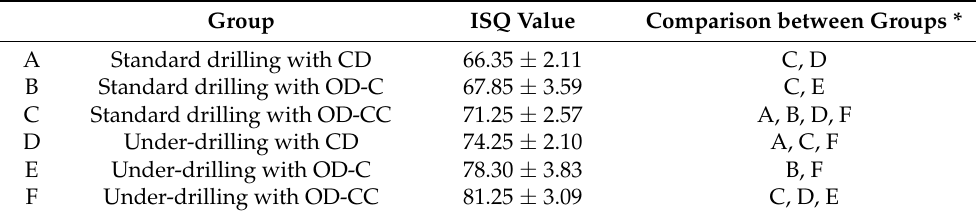
Table 1. Implant stability quotient values in the experimental groups. Group ISQ